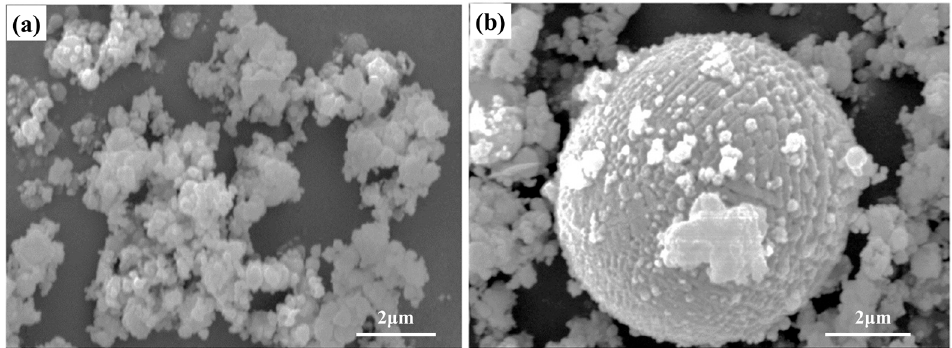
Figure 3. SEM of EAF dust particles: ( a ) irregular agglomerates; ( b ) larger molten spheres [16].